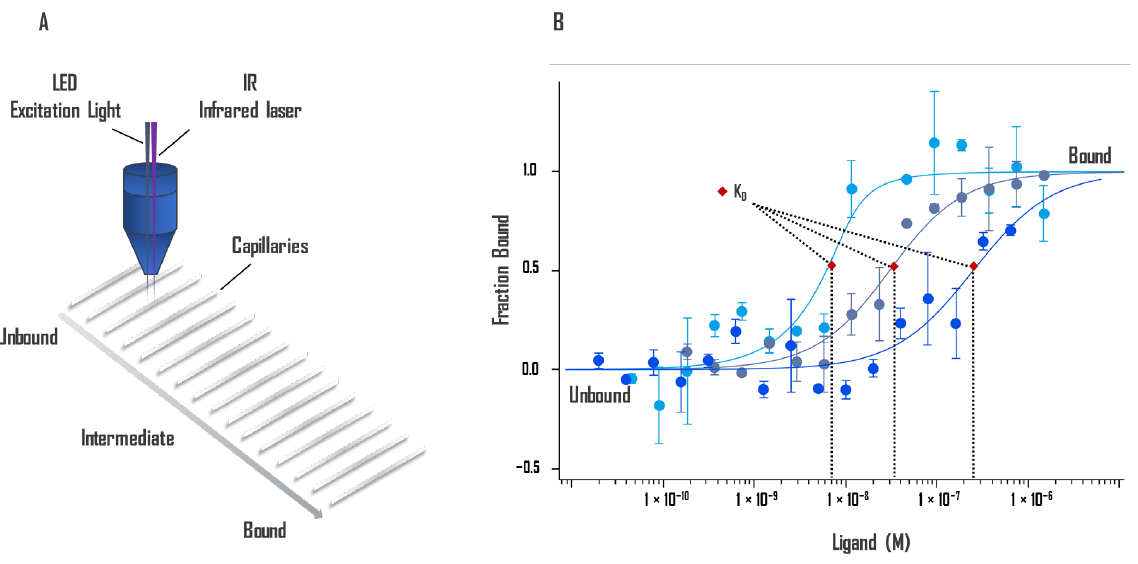
Figure 2. ( A ) Schematic representation of the optical system. Fluorescent molecules in the 16 capillaries are excited and the fluorescence detected by the same objective. An IR laser heats up locally, and thermophoresis of the fluorescent molecules across the temperature gradient is detected. ( B ) The intensity of fluorescence changes due to the movement of molecules away from the heated area differs when the ligand is bound. A binding curve can be established from difference of thermophoresis between the fluorescent molecules of both unbound and bound states against the ligand concentration. Binding constants Kd can be derived from binding curves. Graphs are represented as fraction bound against ligand concentration. Data represent three independent experiments and were fitted to a Kd binding model assuming a 1:1 binding stoichiometry.